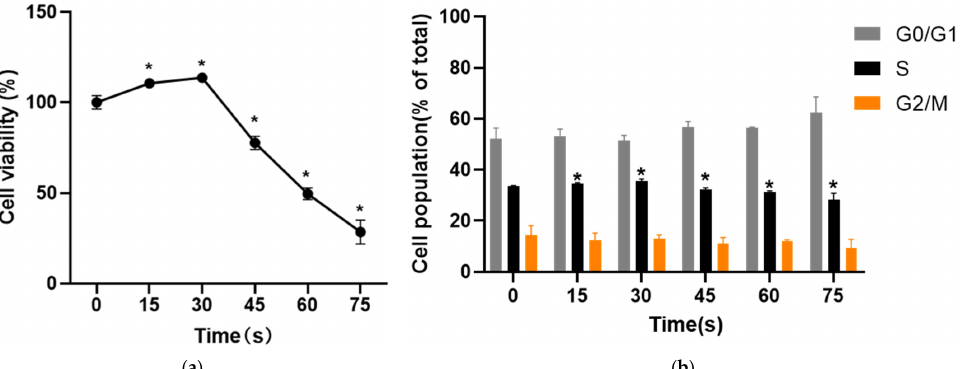
Figure 2. ( a ) Results of MTT. The cell viability increased significantly at 15 s and 30 s and the cell viability decreased at 45 s, 60 s and 75 s. * compared with control group p < 0.05. ( b ) Results of cell cycle. The proportion of cells in S phase in 15 s and 30 s-PAM groups was increased while the proportion of cells in S phase in 45 s, 60 s and 75 s-PAM groups was significantly decreased. * compared with control group p <